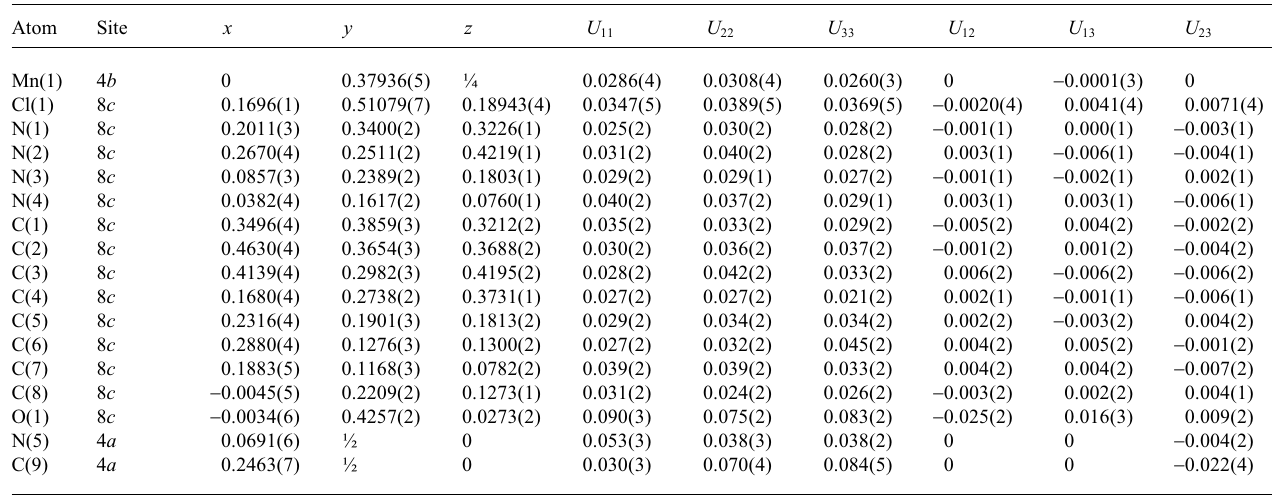
Table 3. Atomic coordinates and displacement parameters (in Å 2 ).